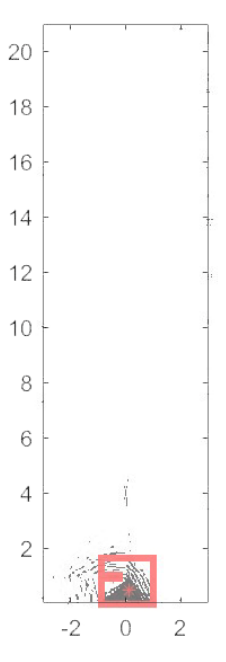
Figure A2 . Magnitude contour image of ground surface vibration measurements at different frequencies.